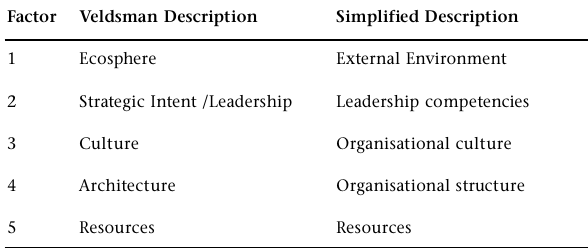
Figure 2: Number of full time employees per SETA